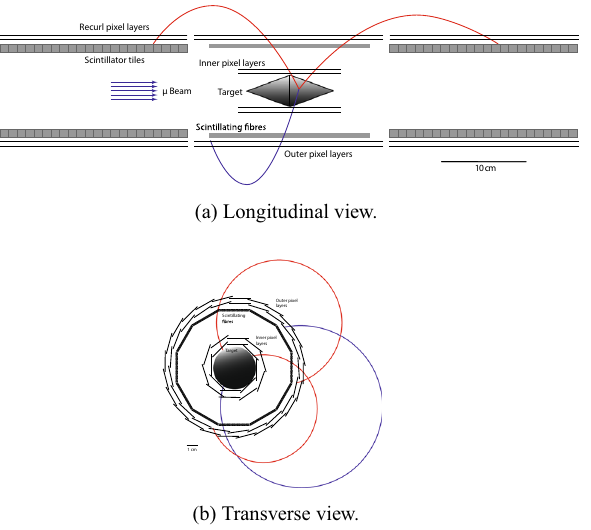
Fig. 40 Schematic of the phase I Mu3e detector [192] as seen a longi- tudinaland b transversetothebeamlinewithapotential μ + → e + e − e + signal